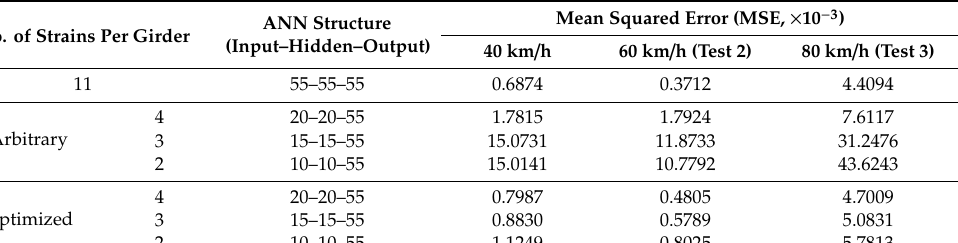
Figure 12. The optimized locations of strain-measurement points on the girders (Unit: mm). Table 7. The results of the ANN test for three test datasets.